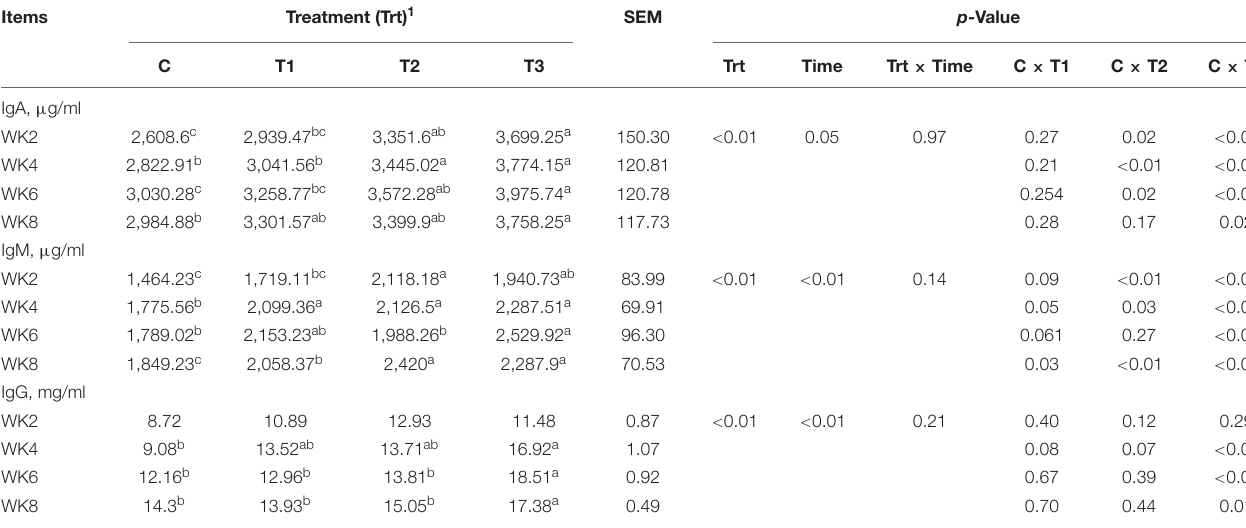
TABLE 3 | The serum immunoglobulin concentrations in Holstein dairy calves fed with different doses of multispecies